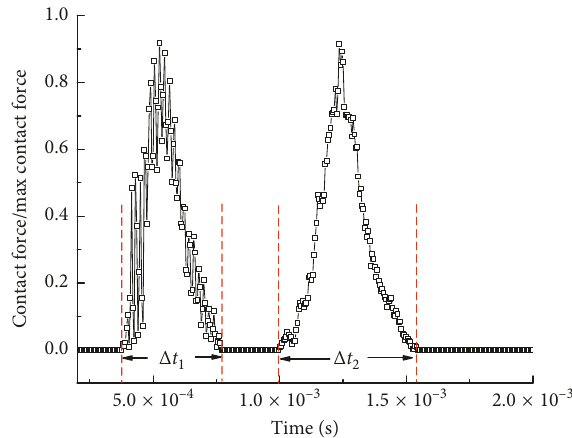
Figure 25: Time history of the contact force on the casing with lower Young’s modulus.